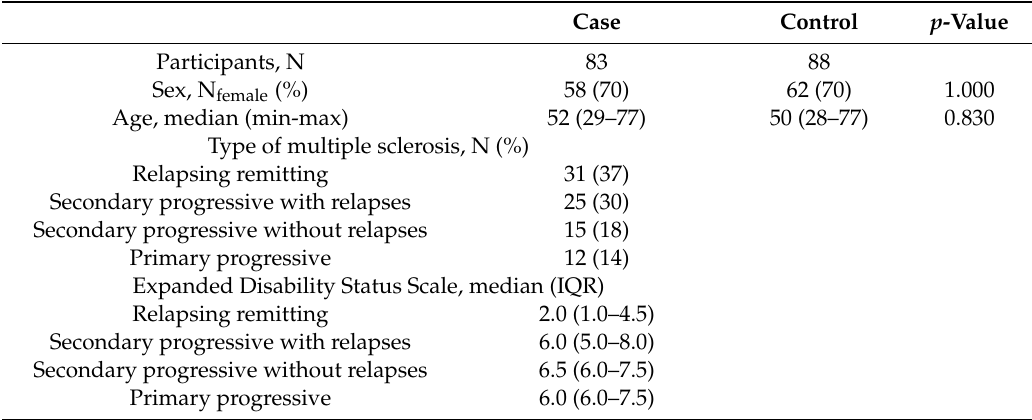
Table 1. Clinical characteristics of the study participants.